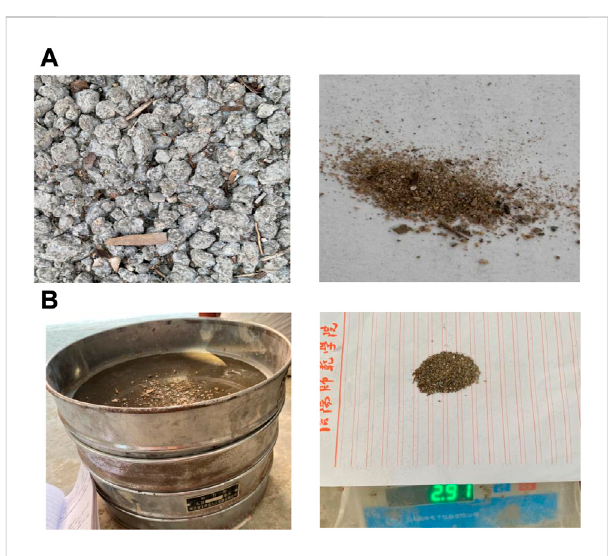
FIGURE 2 Collection and screening of clogging materials: (A) collection of clogging materials; (B) screened clogging